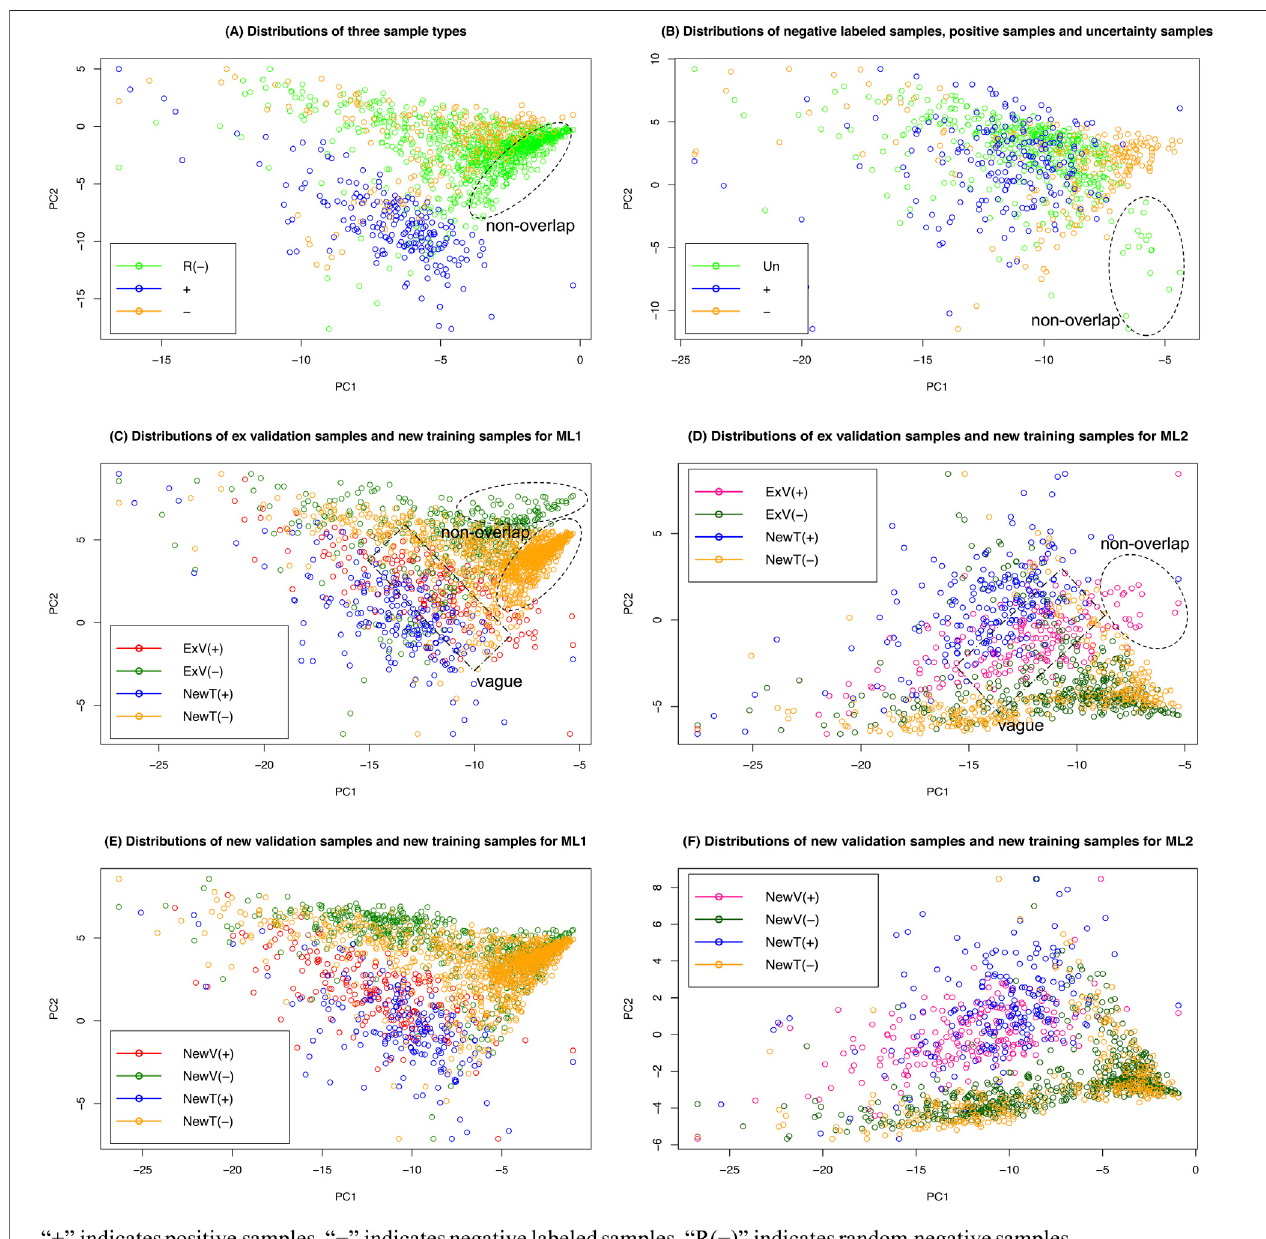
FIGURE 8 | Distribution patterns of various sample types by principal component